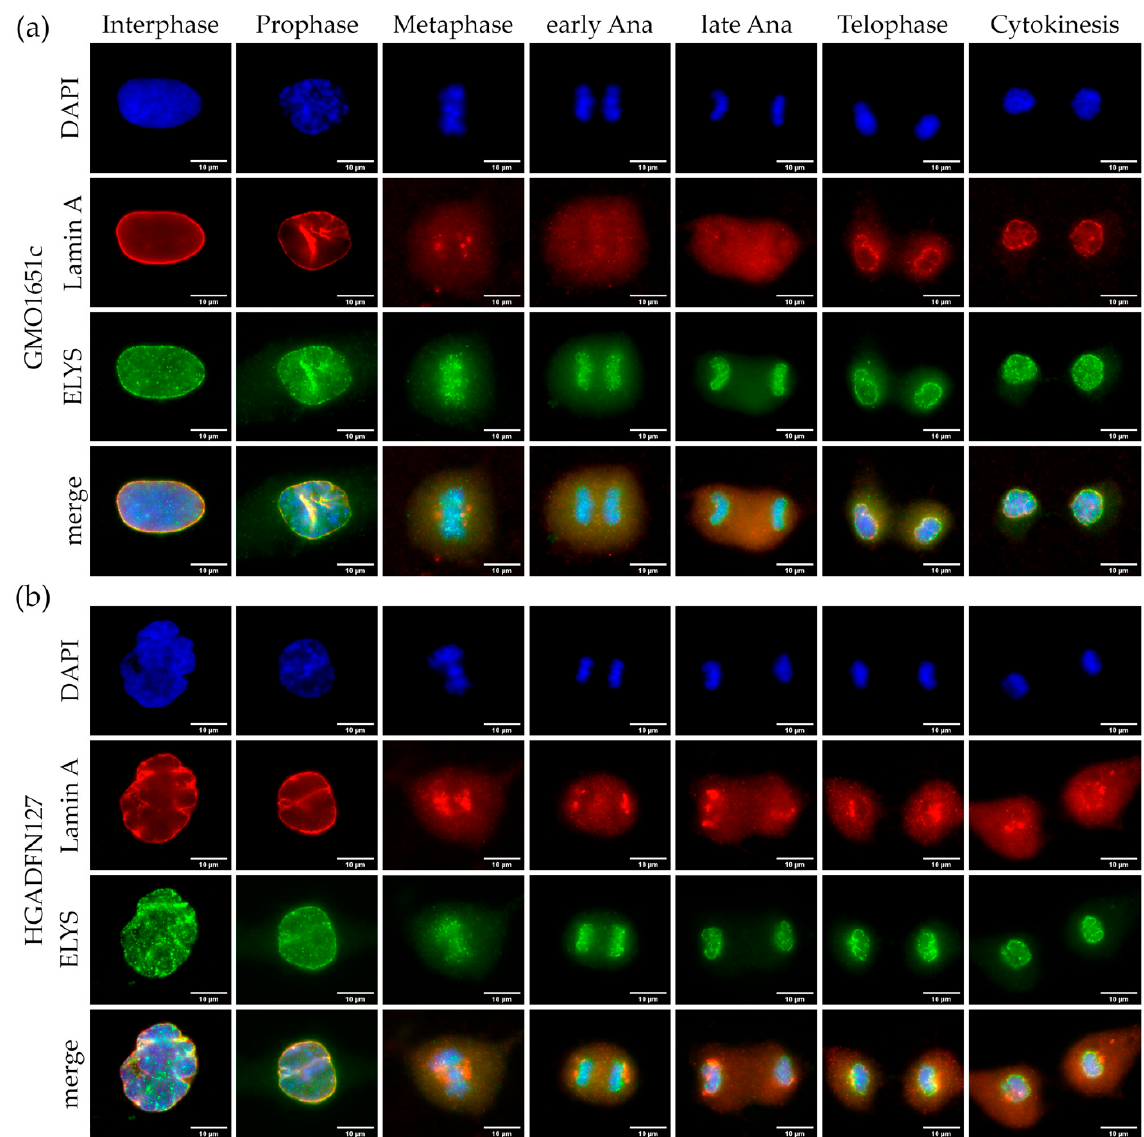
Figure 3. Seeding of NPCs by ELYS on anaphase chromosomes was not affected in HGPS. Immunocytochemistry of ( a ) control (GMO1651c) and ( b ) HGPS (HGADFN127) fibroblasts using α -ELYS and α -LA antibody, counterstained with DAPI. NPCs cluster in interphase HGPS cells ( b ), unlike the evenly spread out punctate pattern in interphase control cells ( a ). Recruitment of ELYS to anaphase chromosomes is not affected in HGPS cells when compared to control. No defect in ELYS localization can be observed in HGPS from prophase to cytokinesis. n ≥